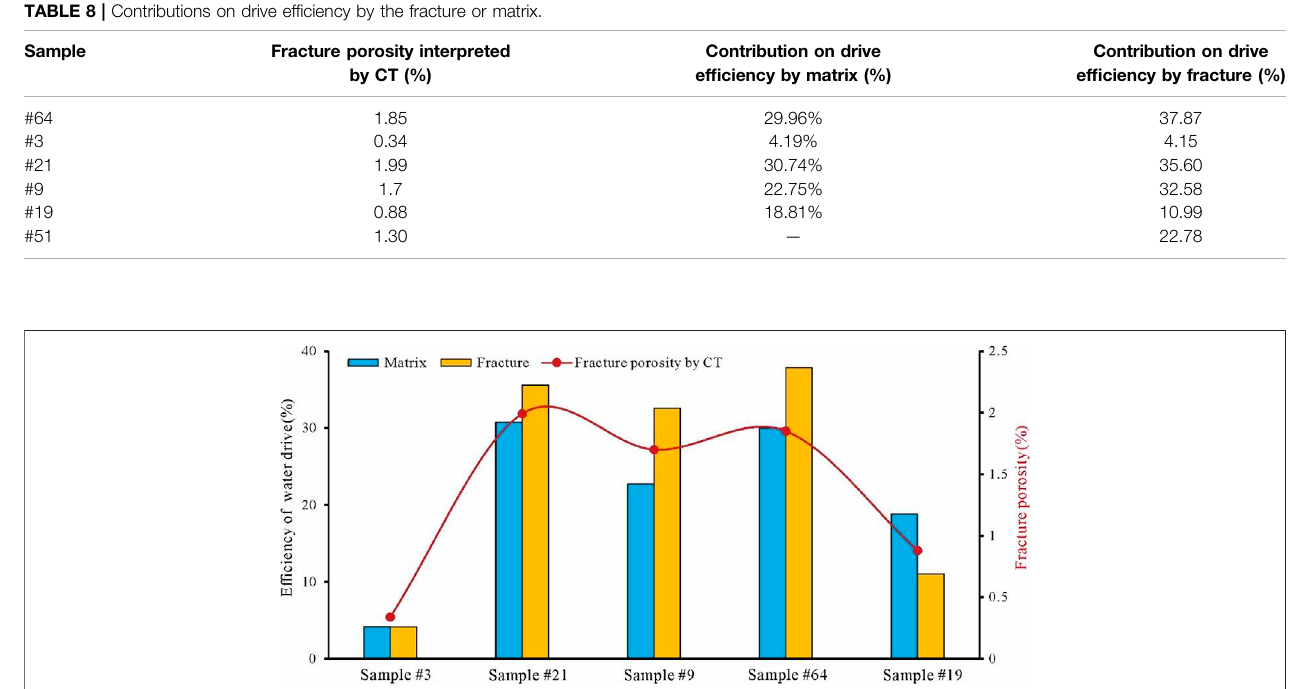
Frontiers in Earth Science |